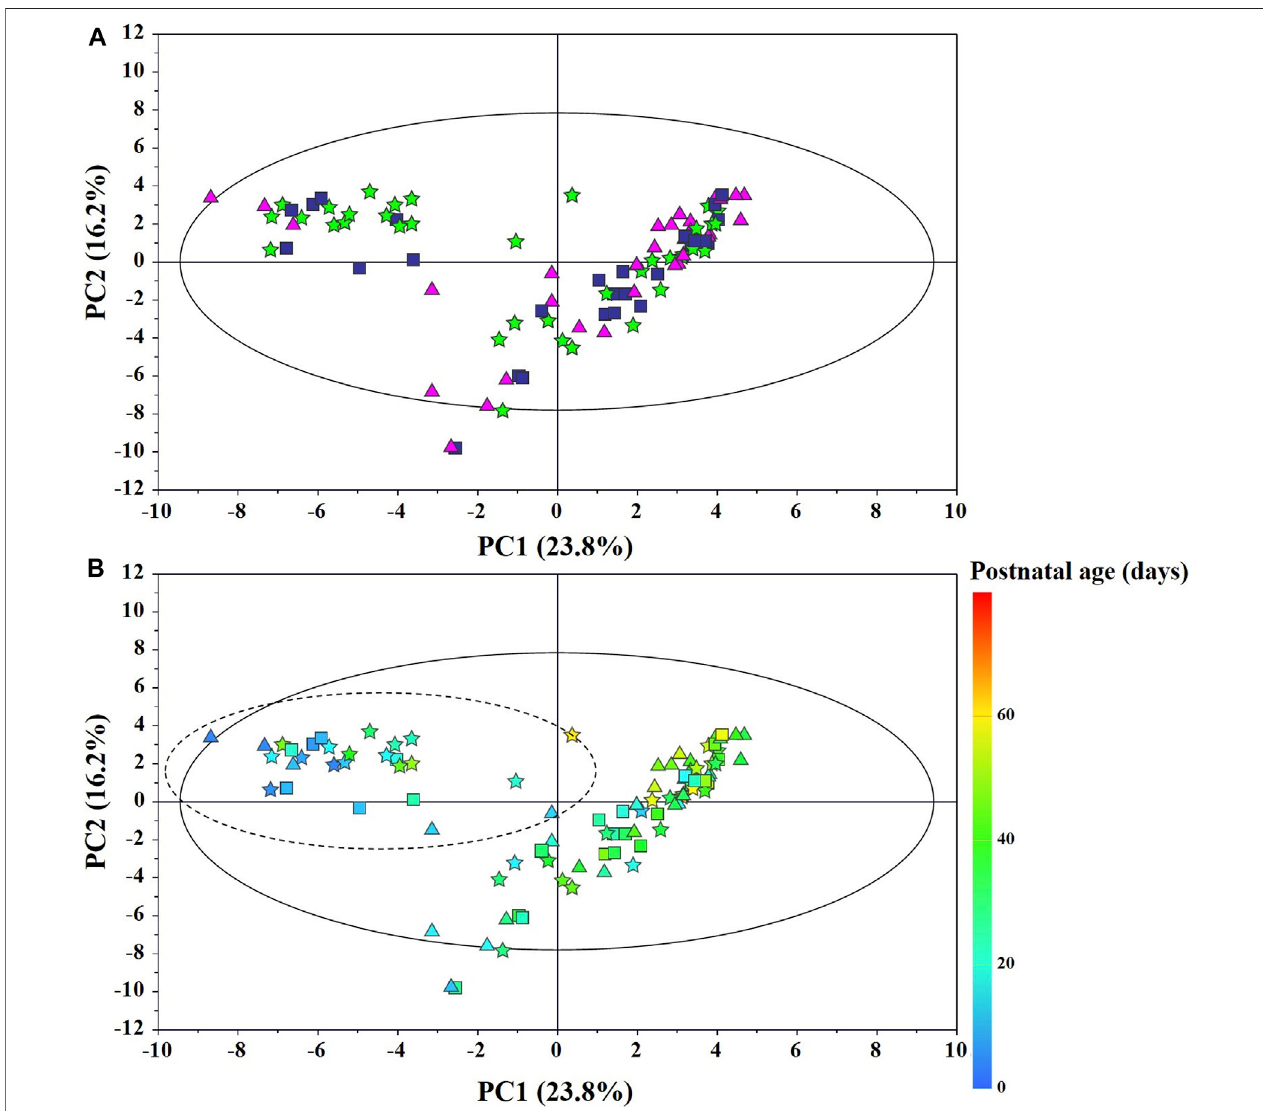
FIGURE 1 | PCA scores plot from the model built with the 1 H-NMR spectra of infant urine samples: (A) + , group 1 NEC; ■ , group 2 FI (feed intolerance without NEC); ▲ , control group 3 GDT (good digestive tolerance without NEC); (B) Scores are coloured according to the postnatal age. Samples in the dotted circle were collected during total parenteral nutrition